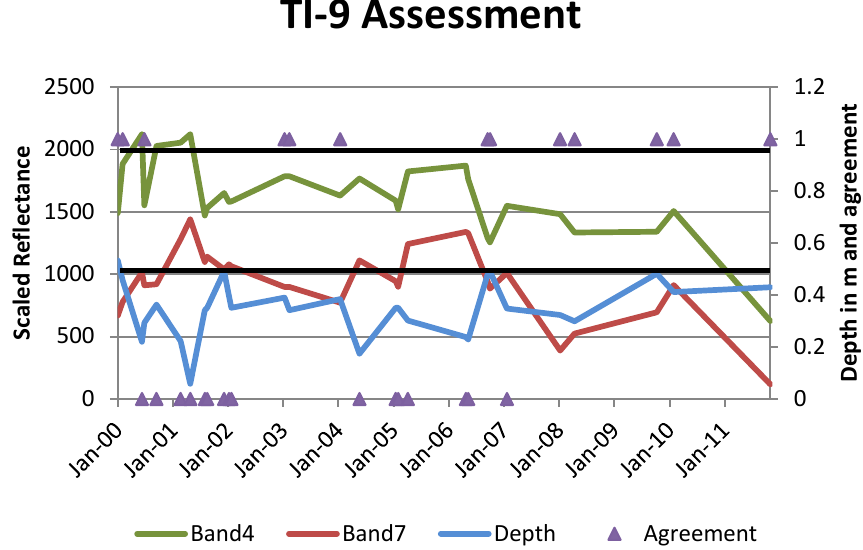
Figure 17. Temporal traces of scaled Landsat band reflectances, water depths modeled using EDEN stage and ground elevation estimates, and agreement (1 = yes, 0 = no, co-located with the Depth axis) given the thresholds applied to MNDWI, TM Band 4 and Band 7